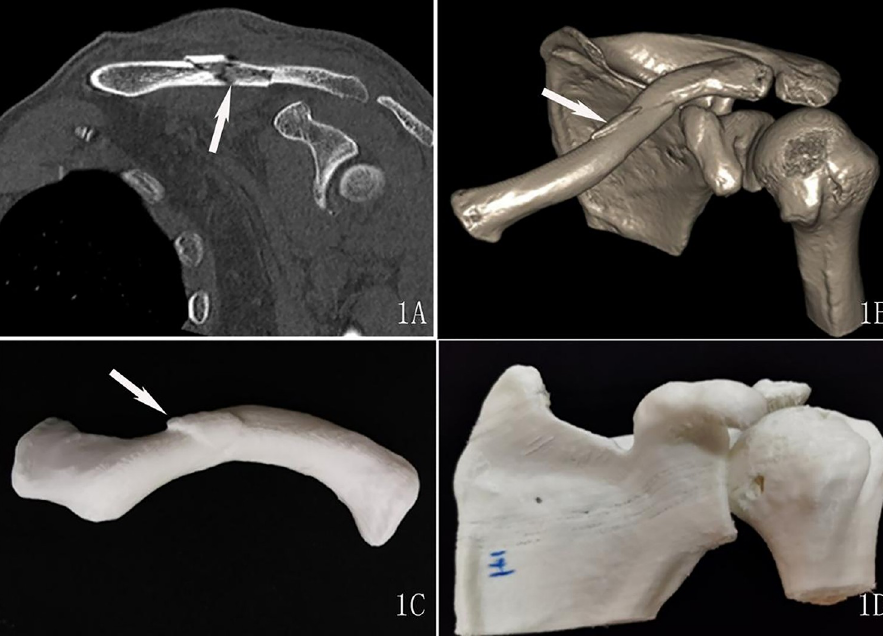
Fig 1. A 51-year-old man with a left clavicle fracture underwent a standard-dose CT scan. 1A: oblique coronal reconstruction images show the fracture line (arrow), and scored 3 points. 1B: Three-dimension reconstruction images show the fracture lines (arrow), 3 points. 1C and 1D: Three-dimension printed model, scored 3 points.